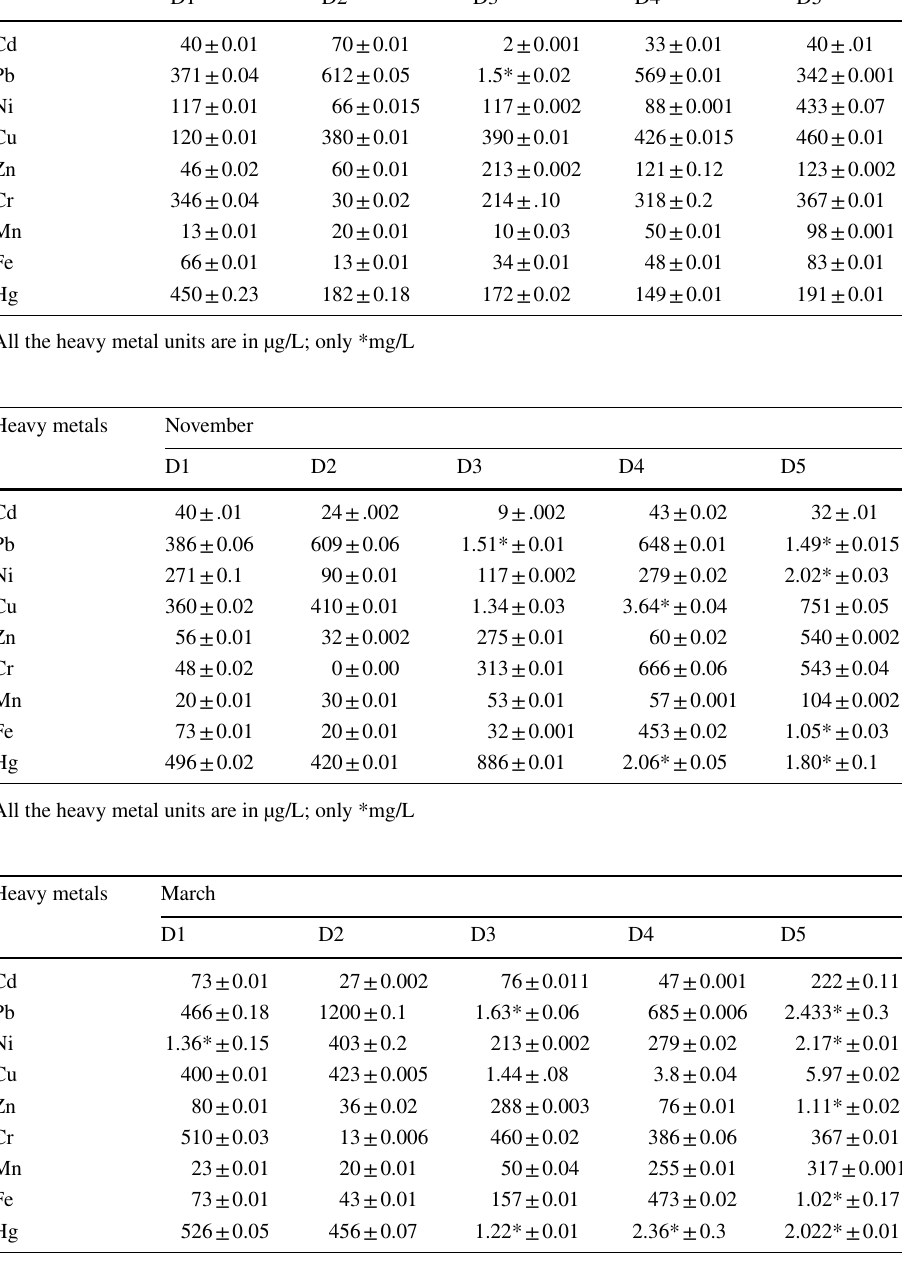
All the heavy metal units are in µg/L;